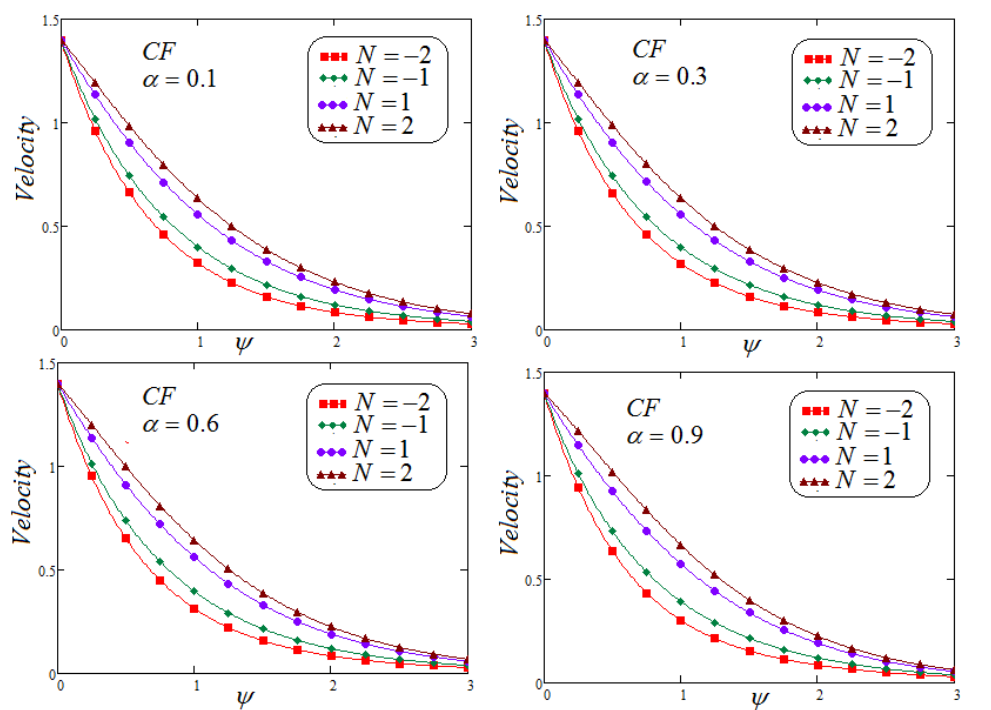
Figure 7. Trace of dimensionless velocity for dissimilar values of N via CF.